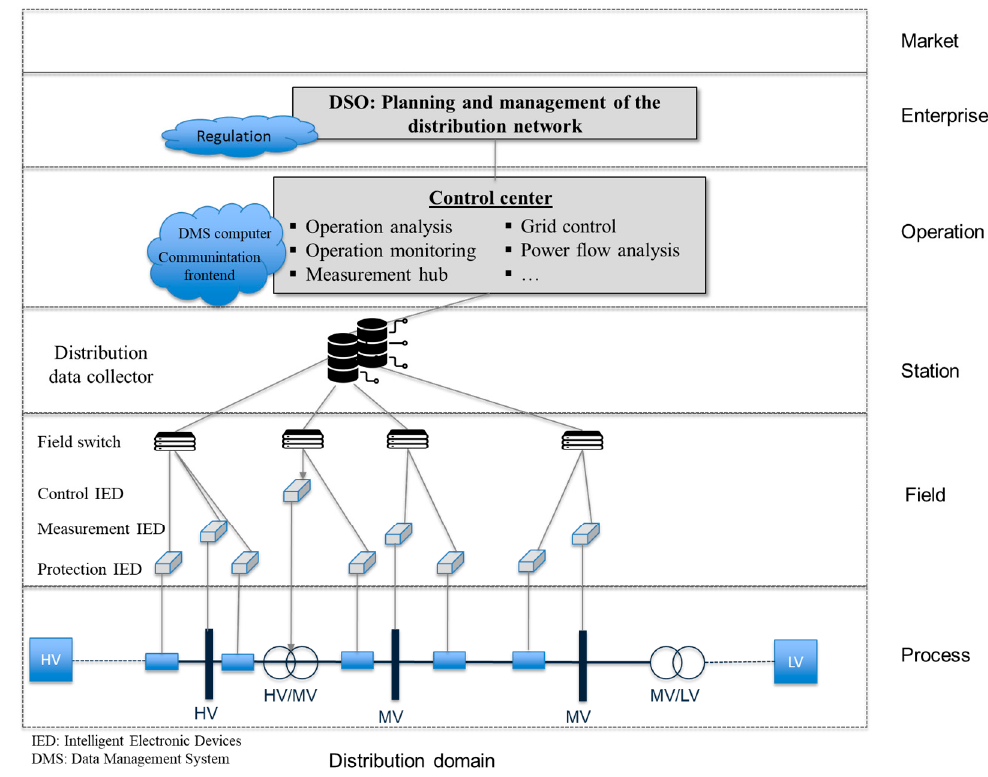
Figure 1. “Component Layer” [9] of the proposed smart grid architecture.